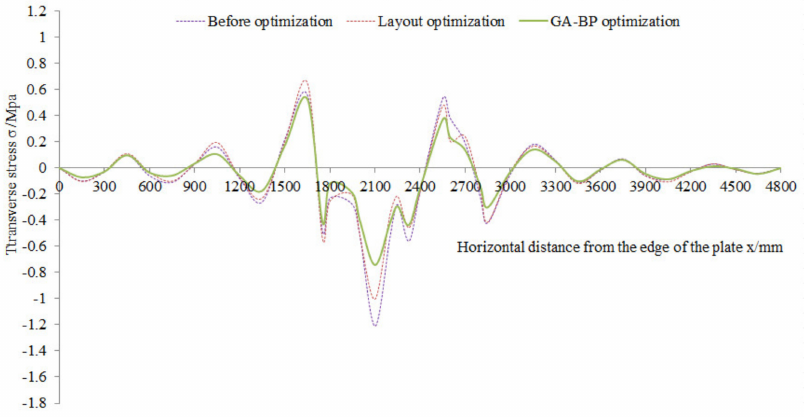
Figure 13. Comparison of the optimized peak stress distribution of the pavement under load